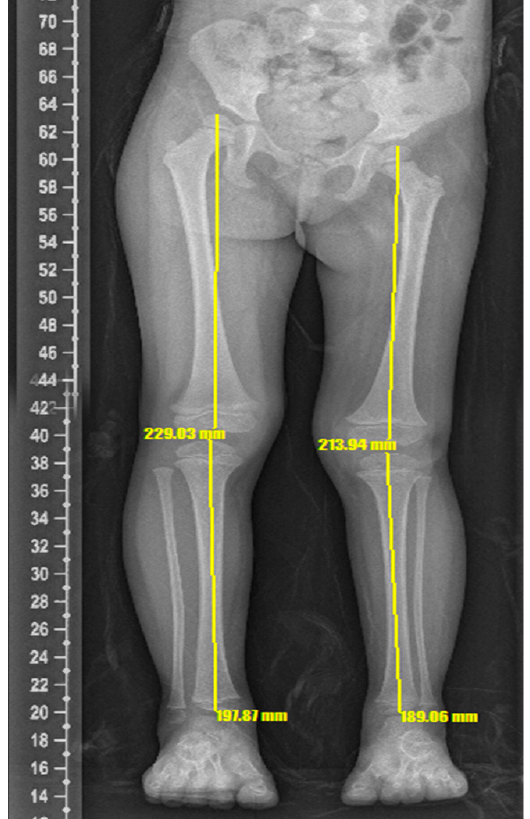
Figure 1. Pre-operative scanogram demonstrating a markedly enlarged right lower limb compared to left lower limb.